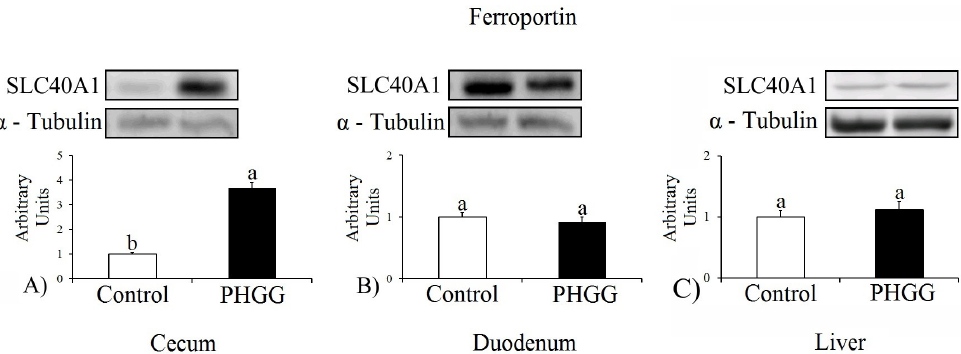
Figure 1. Ferroportin expression. In the cecum, duodenum, and liver of anemic growing rats of the control and the partially hydrolyzed guar gum (PHGG) groups. The protein level was determined by Western blotting and normalized with α -tubulin. The values are means ( n = 8), with standard deviation represented by vertical bars. Different letters represent statistically significant differences ( p ≤ 0.001).